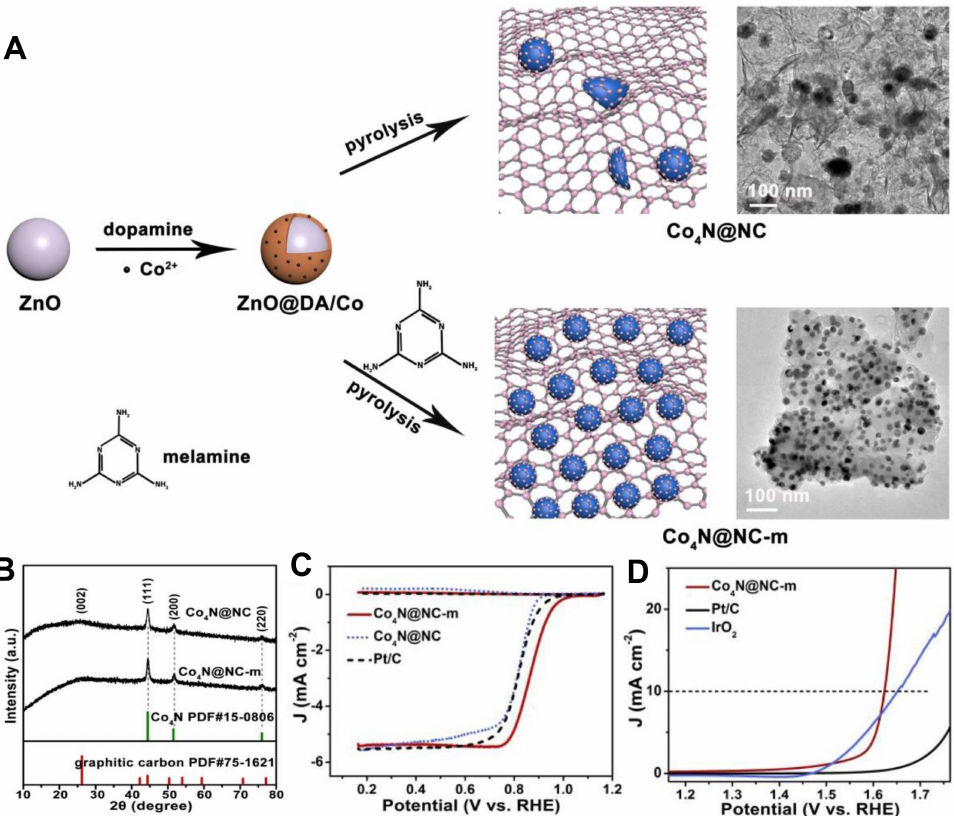
Figure 9. ( A ) Schematic of the formation of Co 4 N@NC-m and Co4N@NC; ( B ) XRD patterns of Co 4 N@NC-m and Co 4 N@NC; ( C ) LSV curves in 0.1 M KOH electrolyte for ORR; ( D ) LSV curves in 0.1 M KOH electrolyte for OER. Reproduced with permission from [100]. Copyright © 2019